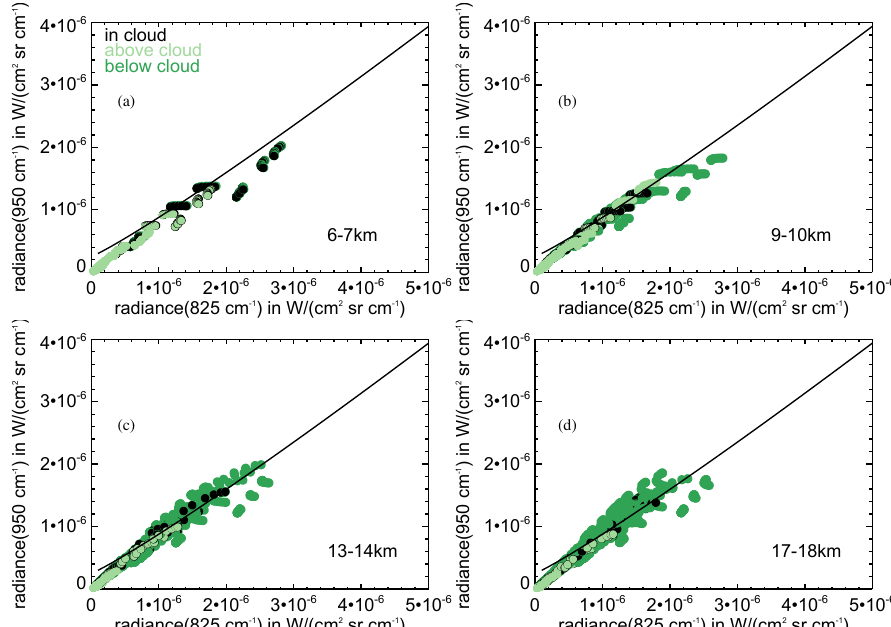
Figure 13. Simulated radiances for sulfate aerosol layers. (a) Sulfate aerosol layer at 6–7km altitude in polar winter, polar summer and mid-latitude atmosphere. (b) Sulfate aerosol layer at 9–10km altitude in polar winter, polar summer and mid-latitude atmosphere. (c) Sulfate aerosol layer at 13–14km altitude in polar winter, polar summer, mid-latitude and equatorial atmosphere. (d) Sulfate aerosol layer at 17–18km altitude in polar winter, polar summer, mid-latitude and equatorial atmosphere. The black line is the ash detection threshold. The tangentaltitudesbelowthesulfatelayerdownto7kmaltitudearecolouredingreen,thetangentaltitudeswithinthesulfatelayerarecoloured in black, and tangent altitudes above the sulfate layer are coloured in light green.